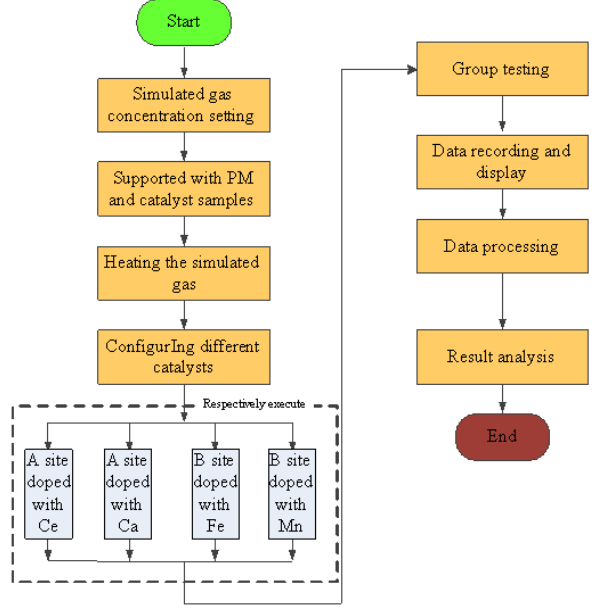
Figure 4. Simulation test flow chart.